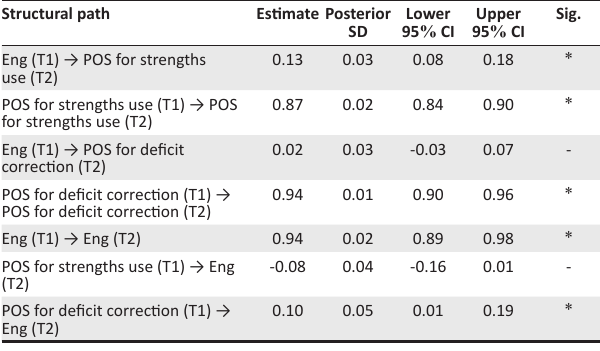
TABLE 6: Regression